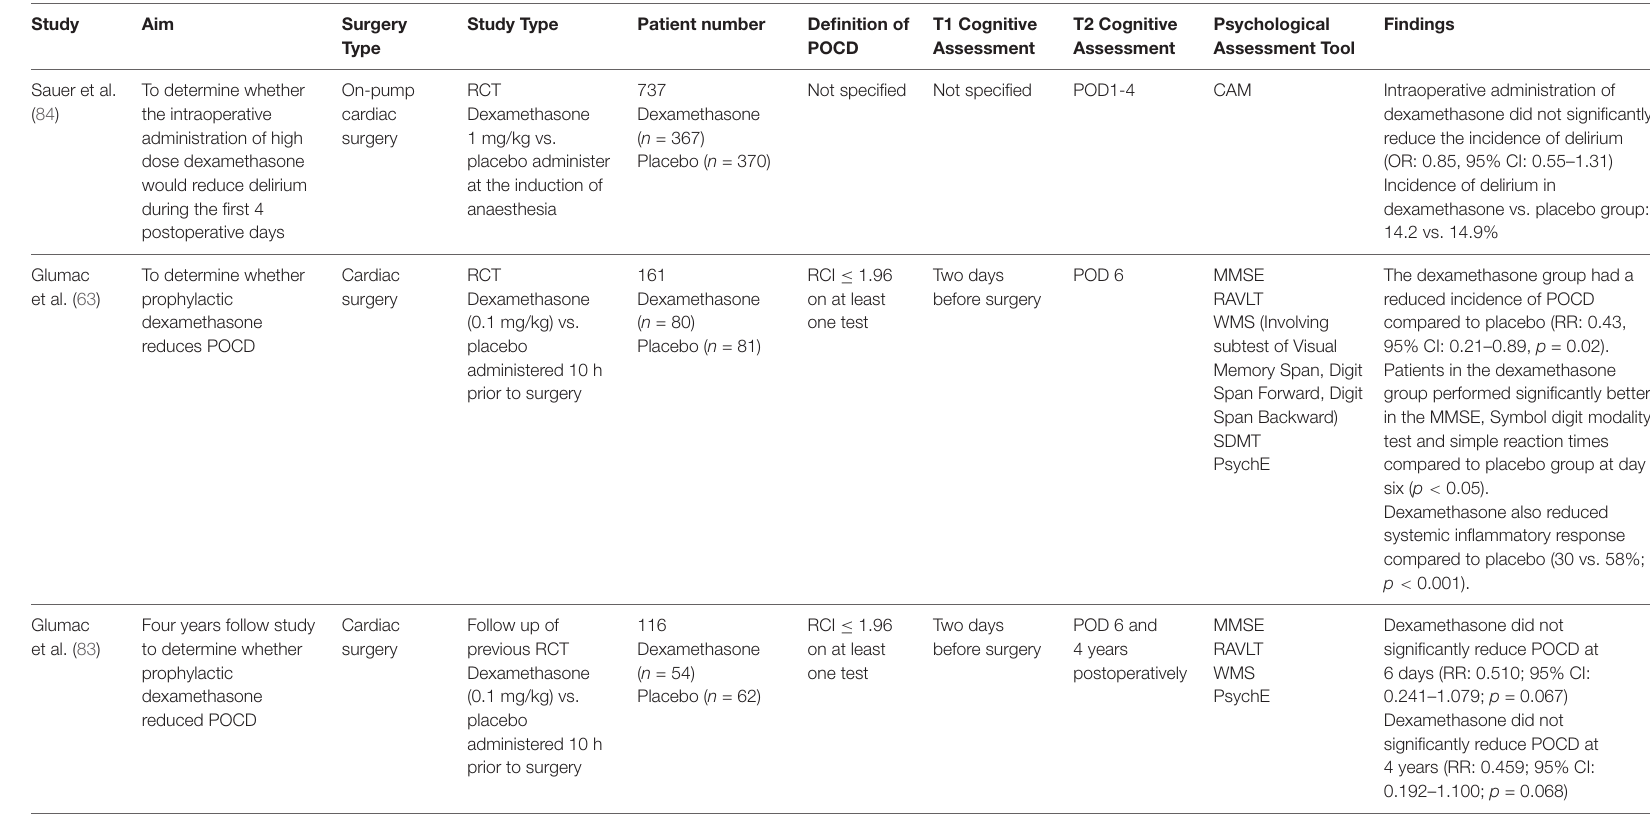
TABLE 2 | The effect of dexamethasone on